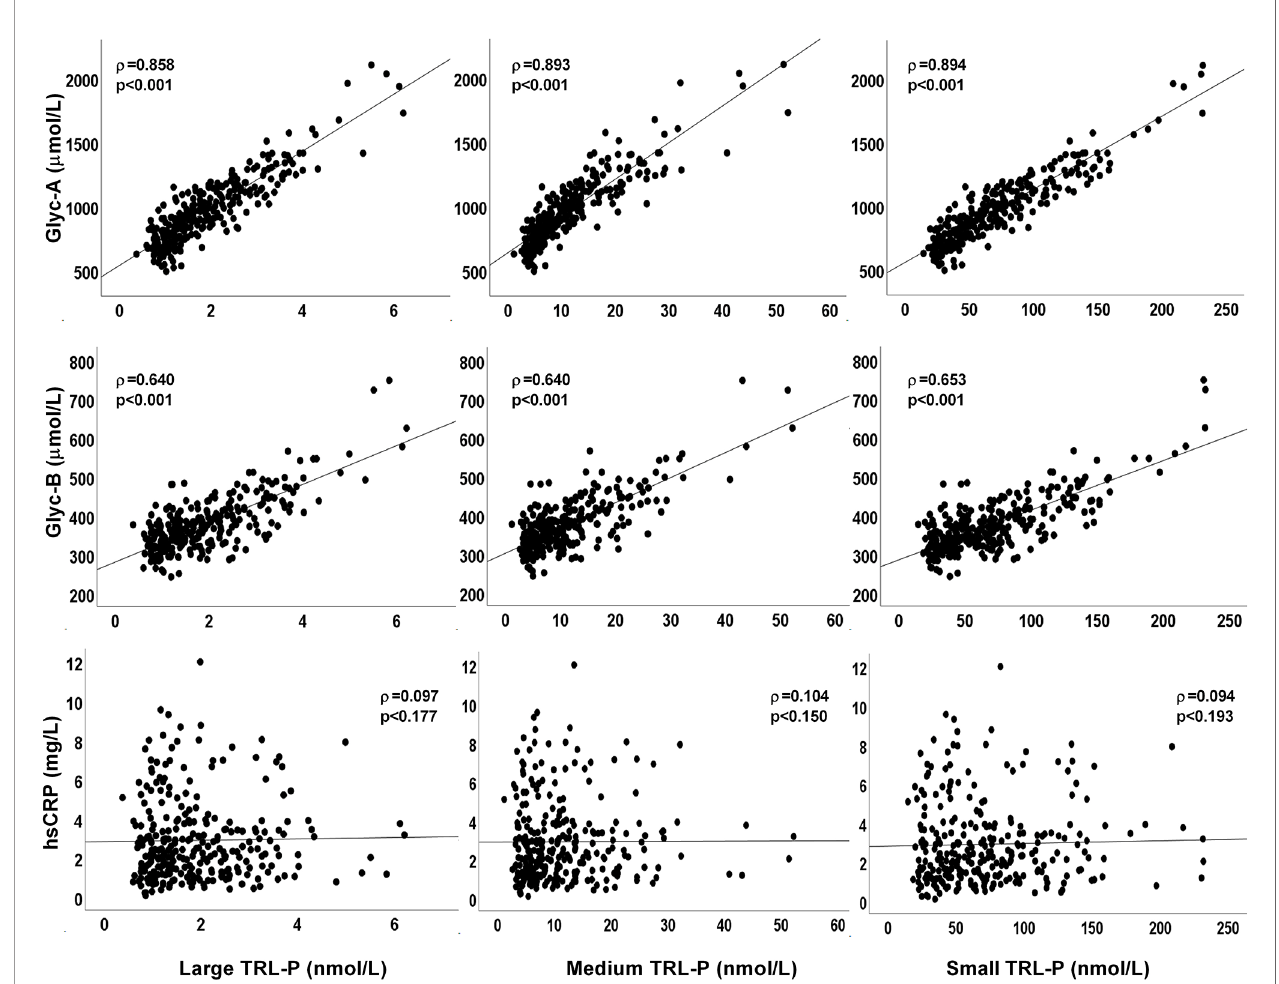
FIGURE 1 | Plots of plasma TRL-P concentrations (large, medium and small particles) with glycoproteins Glyc-A, Glyc-B, and with hsCRP. r from Rho coef fi cients from the Spearman correlation